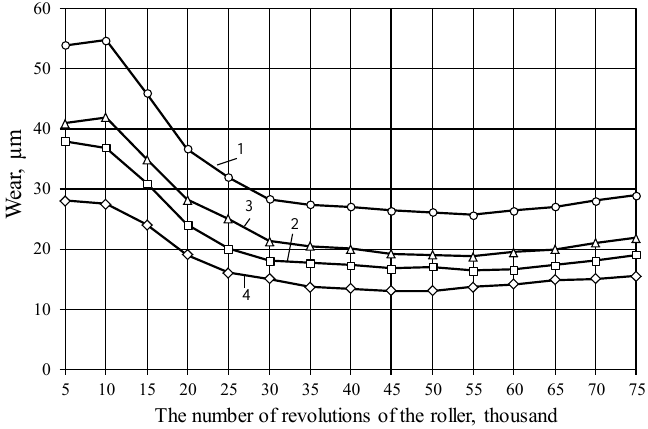
Fig. 6. Dependence of the amount of wear of tribo-coupling friction surfaces of "roller-pad" samples without lubrication depending on the duration of the test (Р = 1.5 MPa, V = 0.5 m/s). Tribocoupling of materials: 1 – "cast